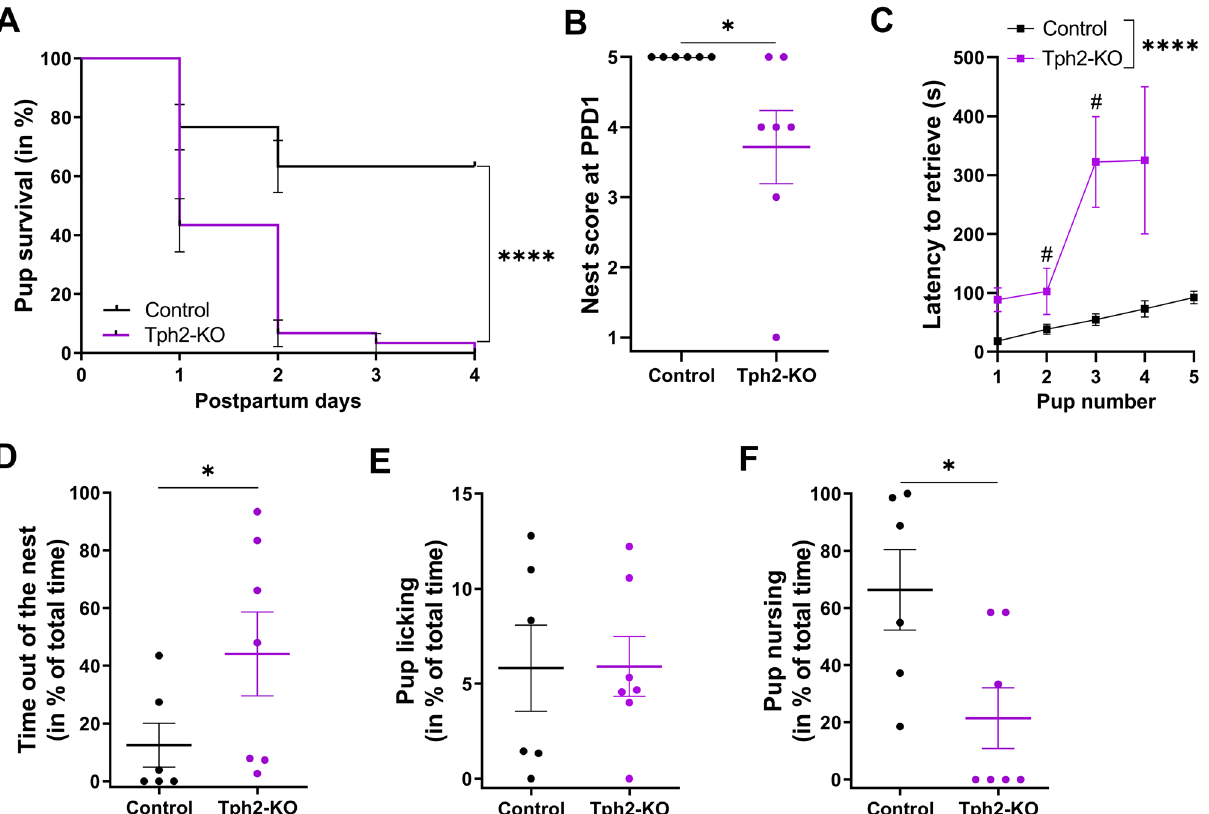
Figure 2. Reproductive success and maternal behaviors are altered in primiparous Tph2-KO mothers. Nulliparous Tph2-KO and control (Tph2 +/+ ) mice were mated to WT males. The number of litters analyzed was n = 7 for Tph2-KO dams and n = 6 for control dams. All litters were culled to 5 pups. ( A ) Contrary to control dams, all the litters from Tph2-KO dams were lost by postpartum day 4; **** p < 0.0001 (mean ± SEM, Log- rank Mantel-Cox test). ( B ) Nest building scores at PPD1 were significantly lower in Tph2-KO dams than in controls, * p < 0.05 (mean ± SEM, Mann–Whitney test). ( C ) Latencies to retrieve pups were significantly reduced in Tph2-KO dams mean ± SEM, **** p < 0.0001 (repeated-measures two-way ANOVA followed by uncorrected Fisher’s LSD: # p = 0.04). None of the Tph2-KO dams was able to retrieve the fifth pup, and 3/7 of Tph2-KO